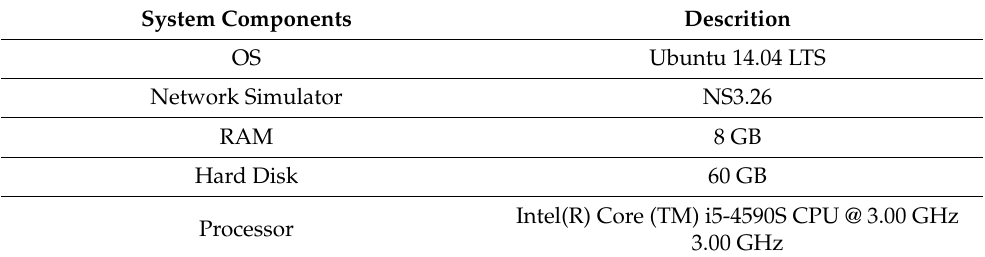
Table 3. Hardware and software requirements of